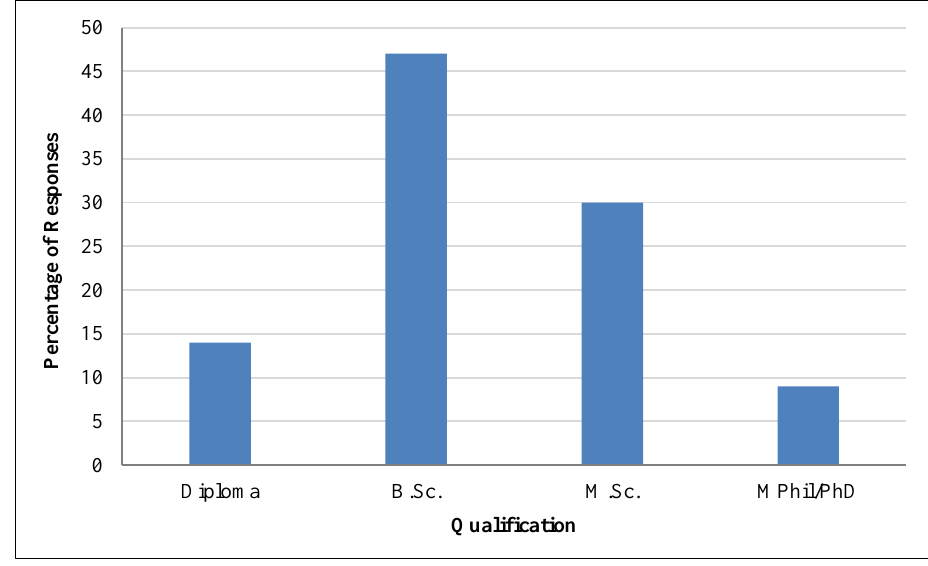
Figure 4. Education demographic of survey participants